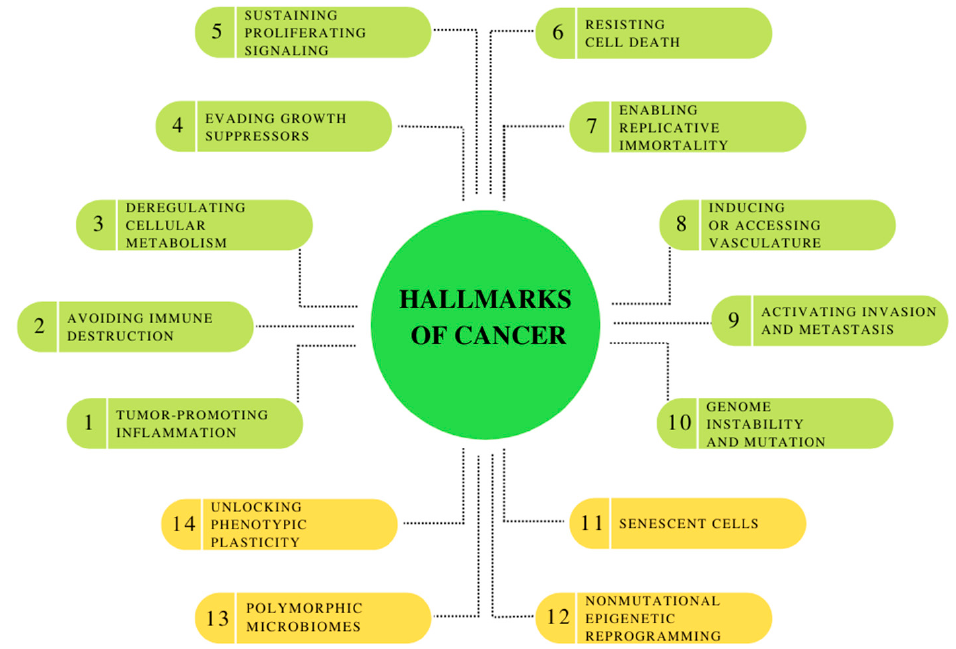
Figure 1. Hallmarks of Cancer: the canonical hallmark capabilities and enabling characteristics, with prospective new additions: unlocking phenotypic plasticity, nonmutational epigenetic reprogram- ming, polymorphic microbiomes and senescent cells. Own elaboration based on [82].